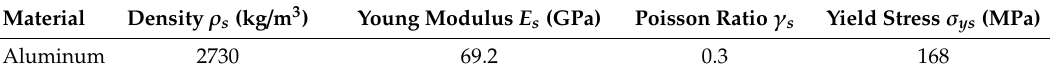
Table 2. Base material parameters [35].